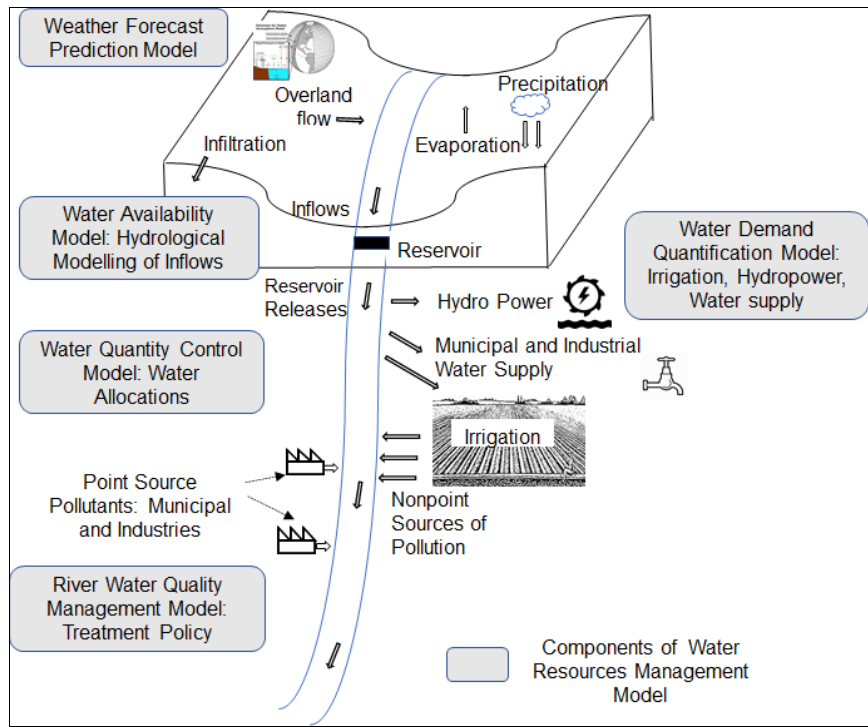
Figure 1. An integrated regional water resource system management model.